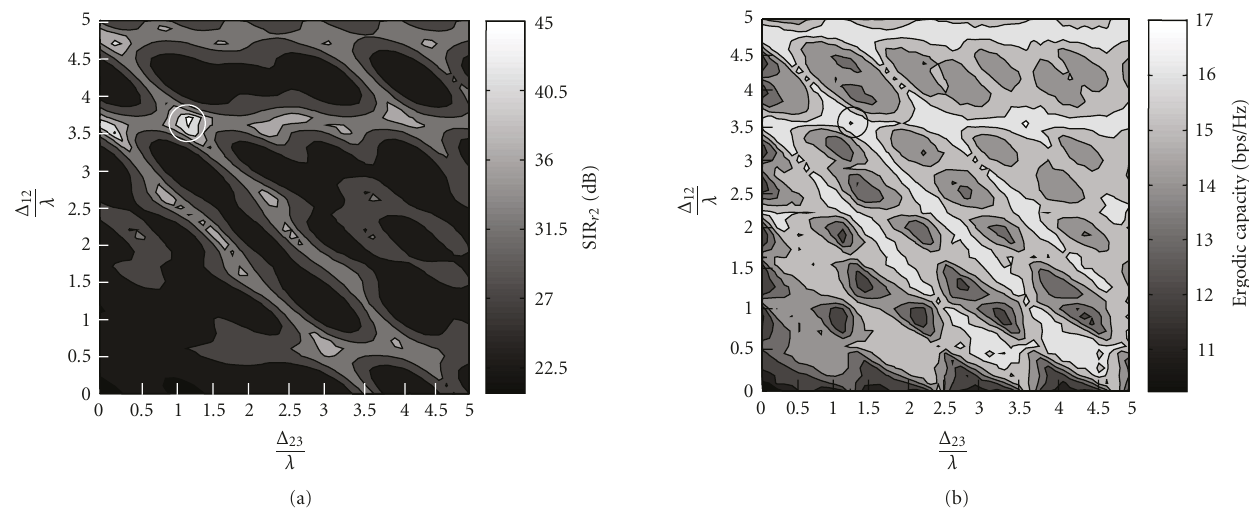
Figure 4: Setting-A: rank-2 approximation of the signal-to-interference ratio SIR r 2 ( Δ , η ) (23) versus Δ 12 /λ and Δ 23 /λ (a) compared with ergodic capacity C ( Δ , η ) (b) ( r = 50 m). Circles denote optimal